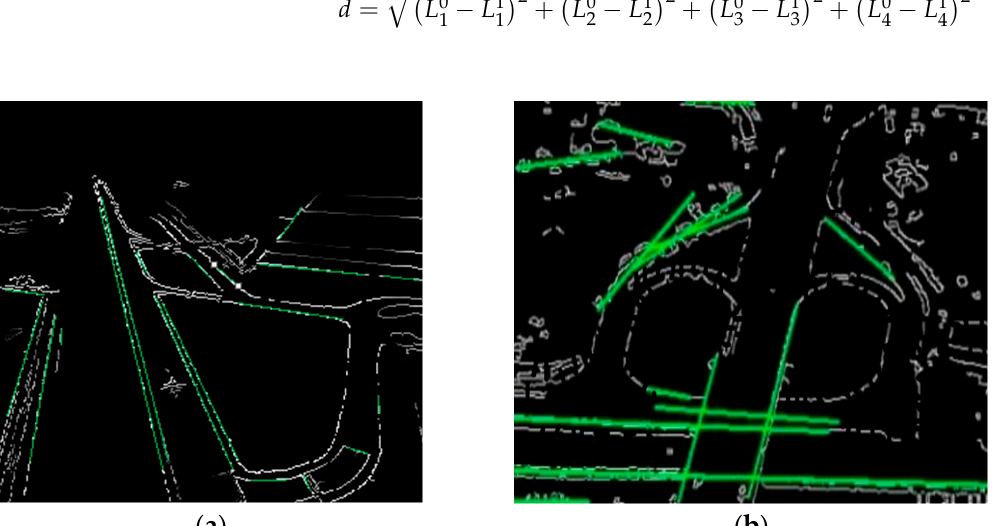
Figure 12. Extract main straight lines through Hough transform. ( a ) Airport image 1 extracting lines; the algorithm in this paper. ( b ) Road image 2 extracting